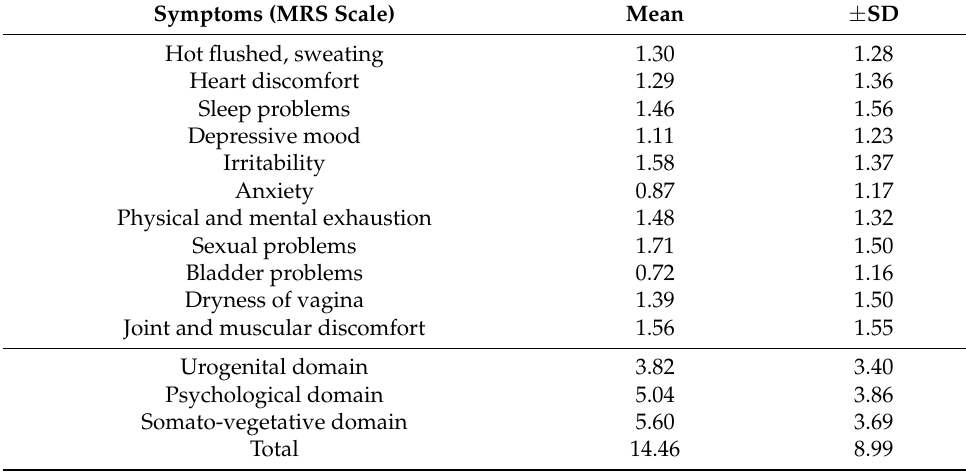
Table 2. The characteristics of menopausal symptoms (MRS scale) in the participants.